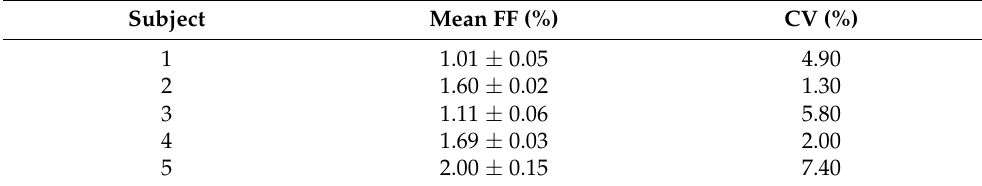
Table 1. Fat quantification and its repeatability results.